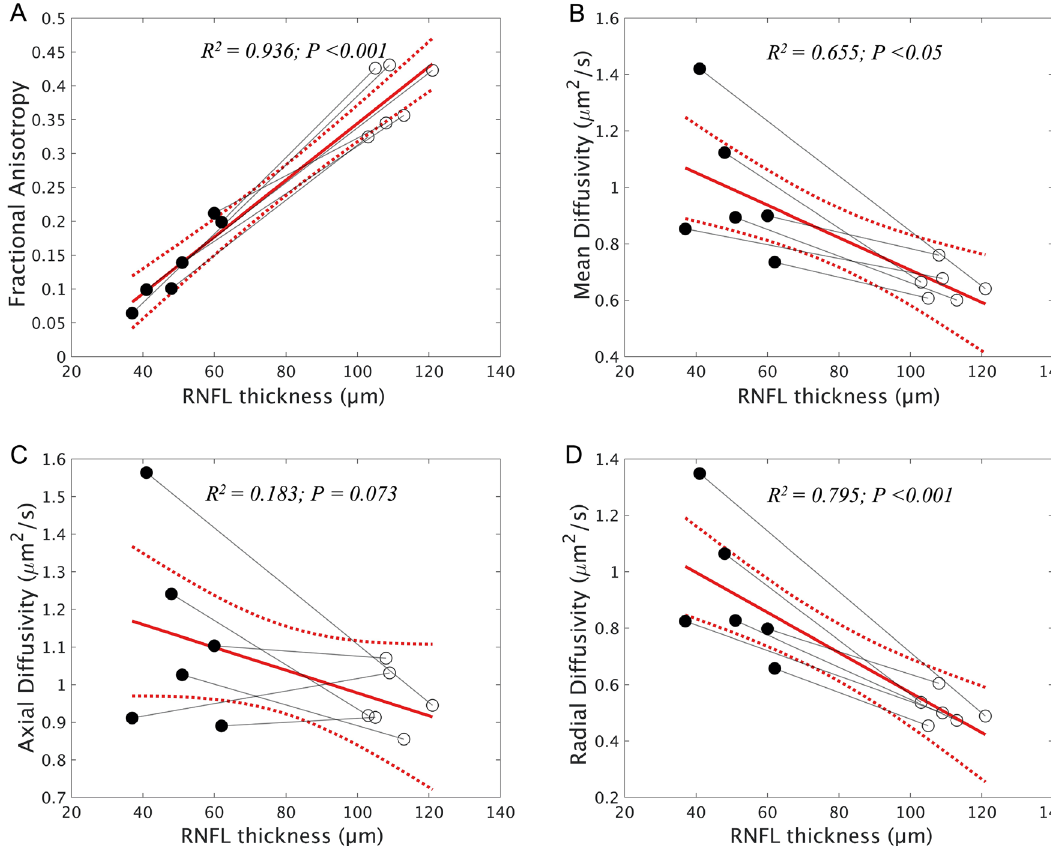
Figure 4. Correlation of diffusion measures and retinal nerve fiber layer (RNFL) thickness of the optic nerve head of atrophic ONs in patients with unilateral optic atrophy. Correlation between average RNFL thickness and average fractional anisotropy ( A ), mean diffusivity ( B ), axial diffusivity ( C ), and radial diffusivity ( D ). Correlations within patients are indicated by each solid gray line, with closed points marking eyes with atrophic optic nerves and open points marking non-affected eyes. A least-squares regression estimate is indicated by the solid line with red color and its 95% confidence bounds as the dashed